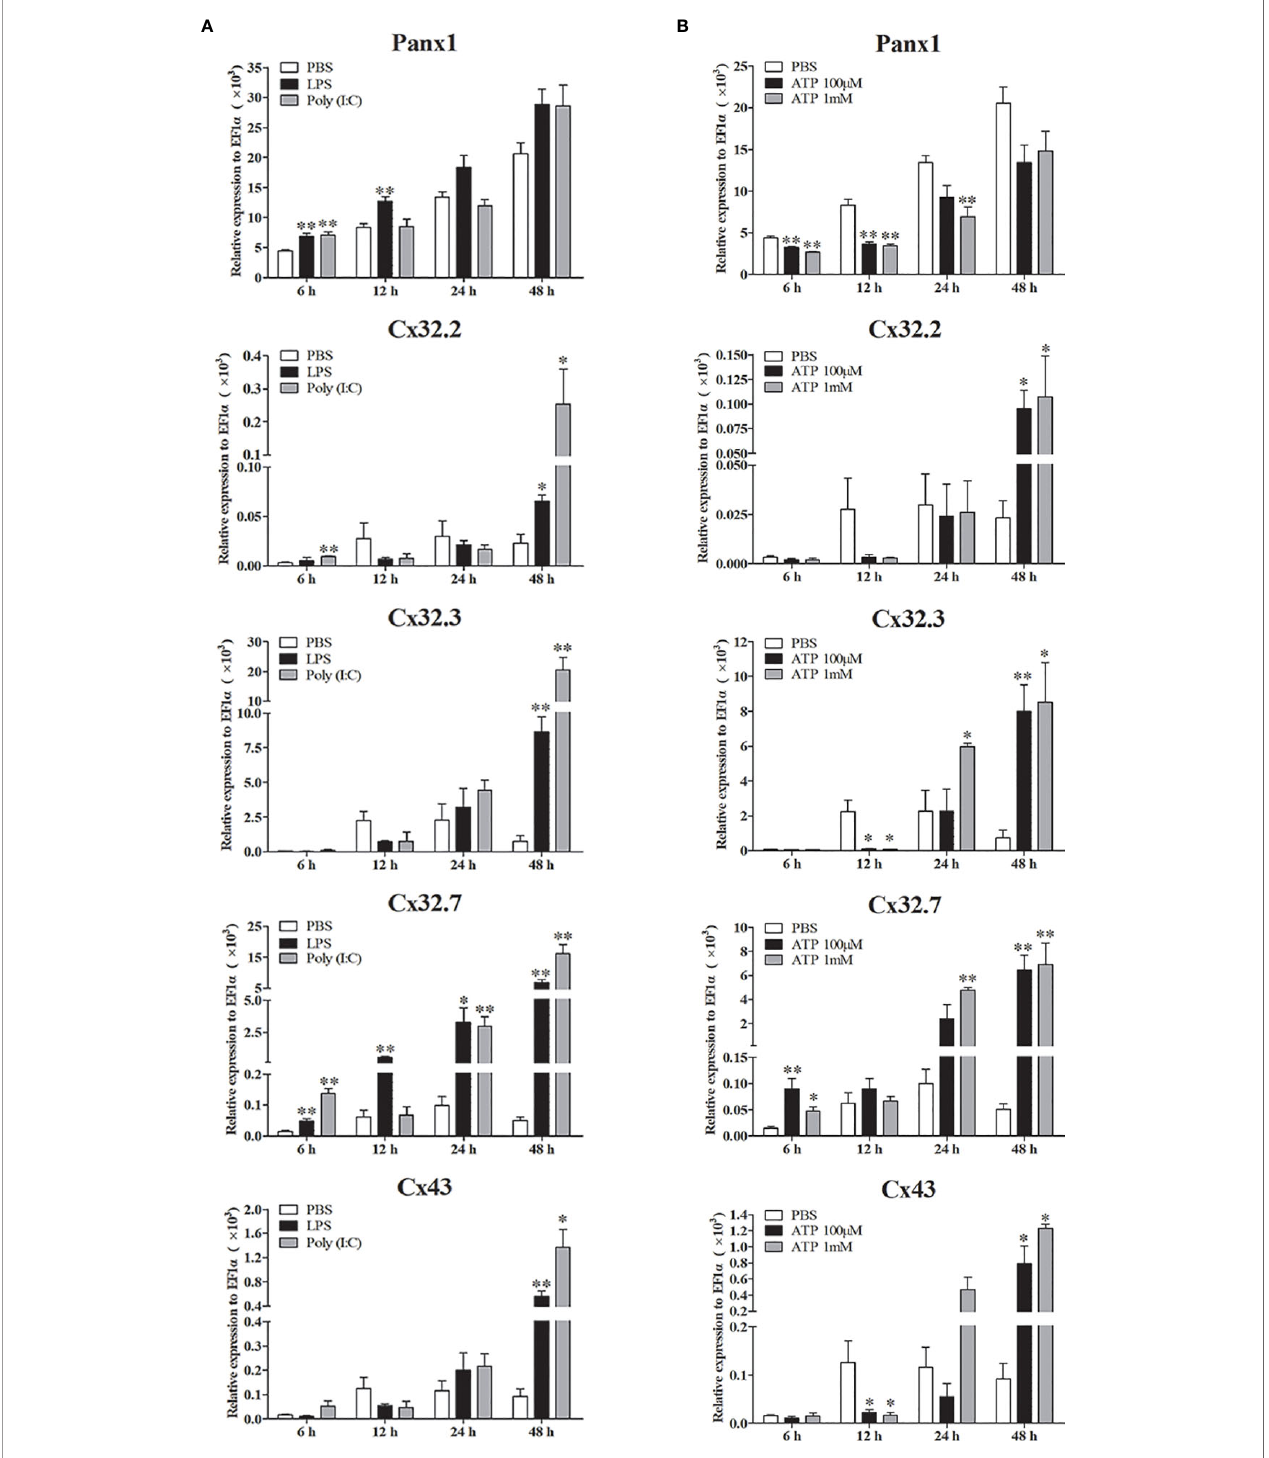
FIGURE 7 | Expression of Lm Panx1, Lm Cx32, and Lm Cx43 in primary head kidney leukocytes after stimulation with LPS, poly(I:C) (A) or ATP (B) . Primary head kidney leukocytes were isolated from the spotted sea bass head kidney and stimulated with LPS (100 µg/mL), poly(I:C) (50 µg/mL), 100 µM ATP, 1 mM ATP, or PBS (control). The relative expression levels of target genes were normalized to that of EF1 a . The data are shown as mean +SEM (N = 4). * p < 0.05, ** p < 0.01 are considered signi fi cant